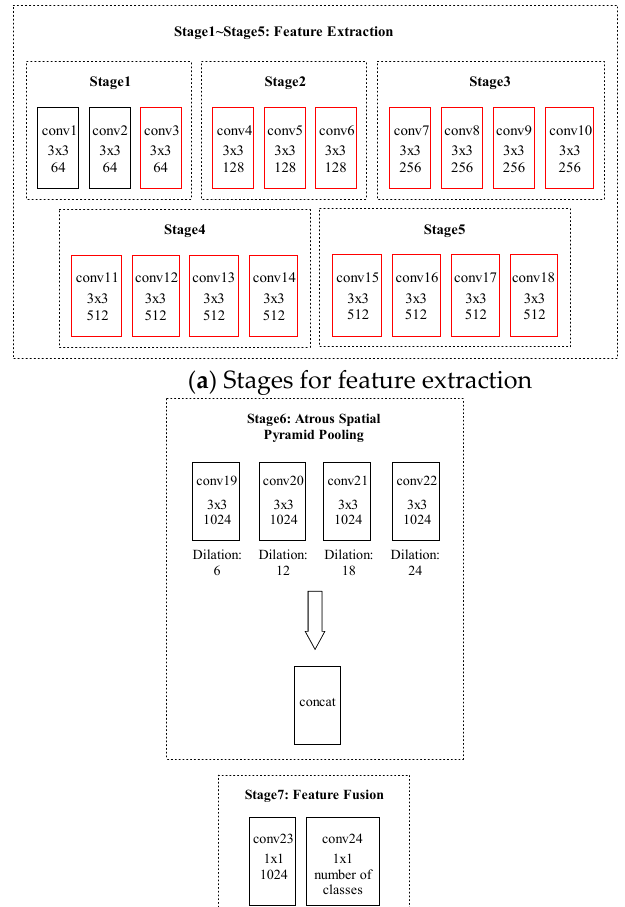
Figure 3. Architecture of an SM. Each block denotes one convolutional layer. ReLU nonlinearities are used throughout, and max pooling occurs between adjacent groups of convolutional layers. The first line within each block denotes the name of the layer, the second line shows the kernel size, and the third line shows the number of output channels. ( a ) The five stages for extracting basic features. ( b ) Task-specific stages. A mechanism known as ASPP [9] is adopted to enable 3 × 3 filters to have different field-of-views. Four parallel filters with different field-of-views are adopted to extract the features for pixel classification. The kernels in the layers from conv19 to conv22 are with size 3 × 3 but differ in the distance between weights in the kernels. The heat-maps generated by the four parallel convolutional layers are fused in Stage